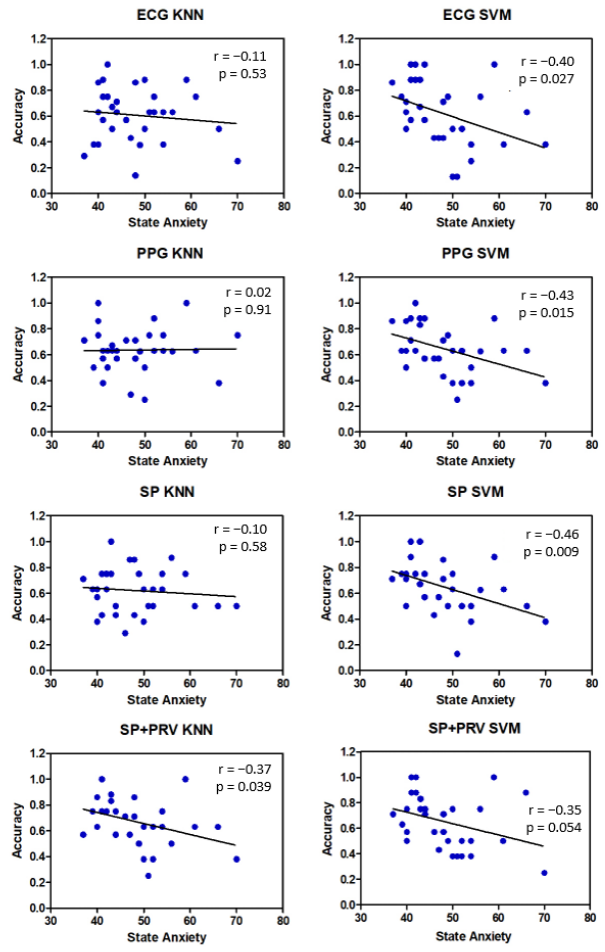
Figure 16. Classification of Dominance emotional variable. Correlation plots of accuracy and anxiety values. The 31 accuracy values refer to individual volunteers.